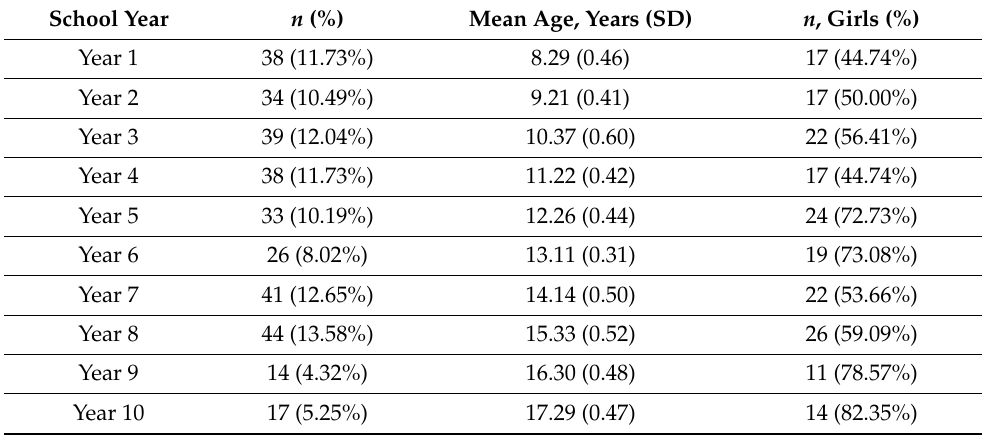
Table 2. Distribution of the 324